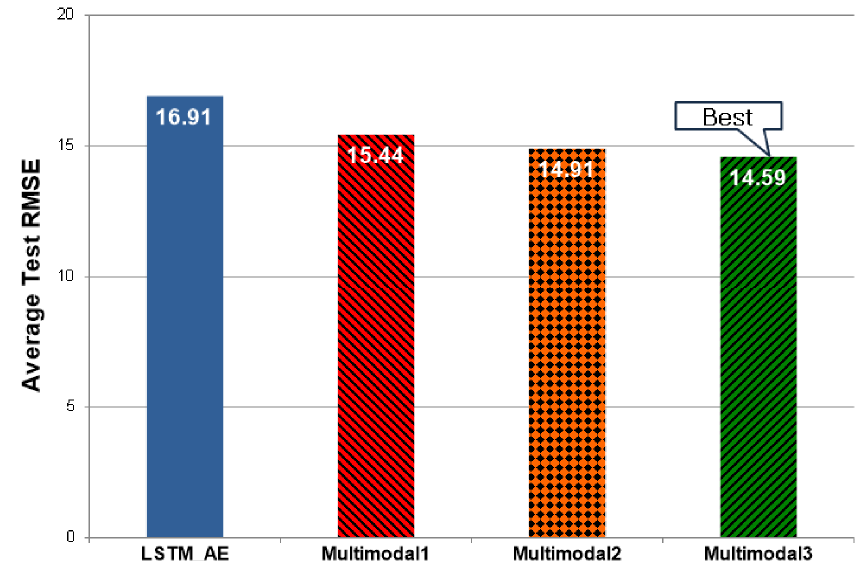
LSTM_AE + VGG19, was 14.59, which decreased by 2.15% compared with Multimodal2.